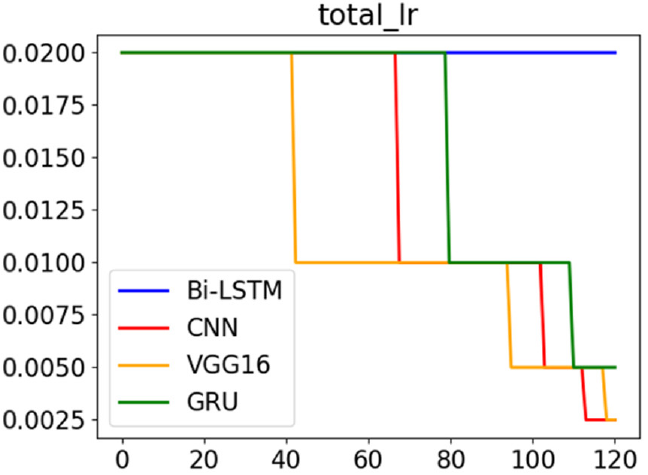
Figure 8. The curve of the learning rate per model.